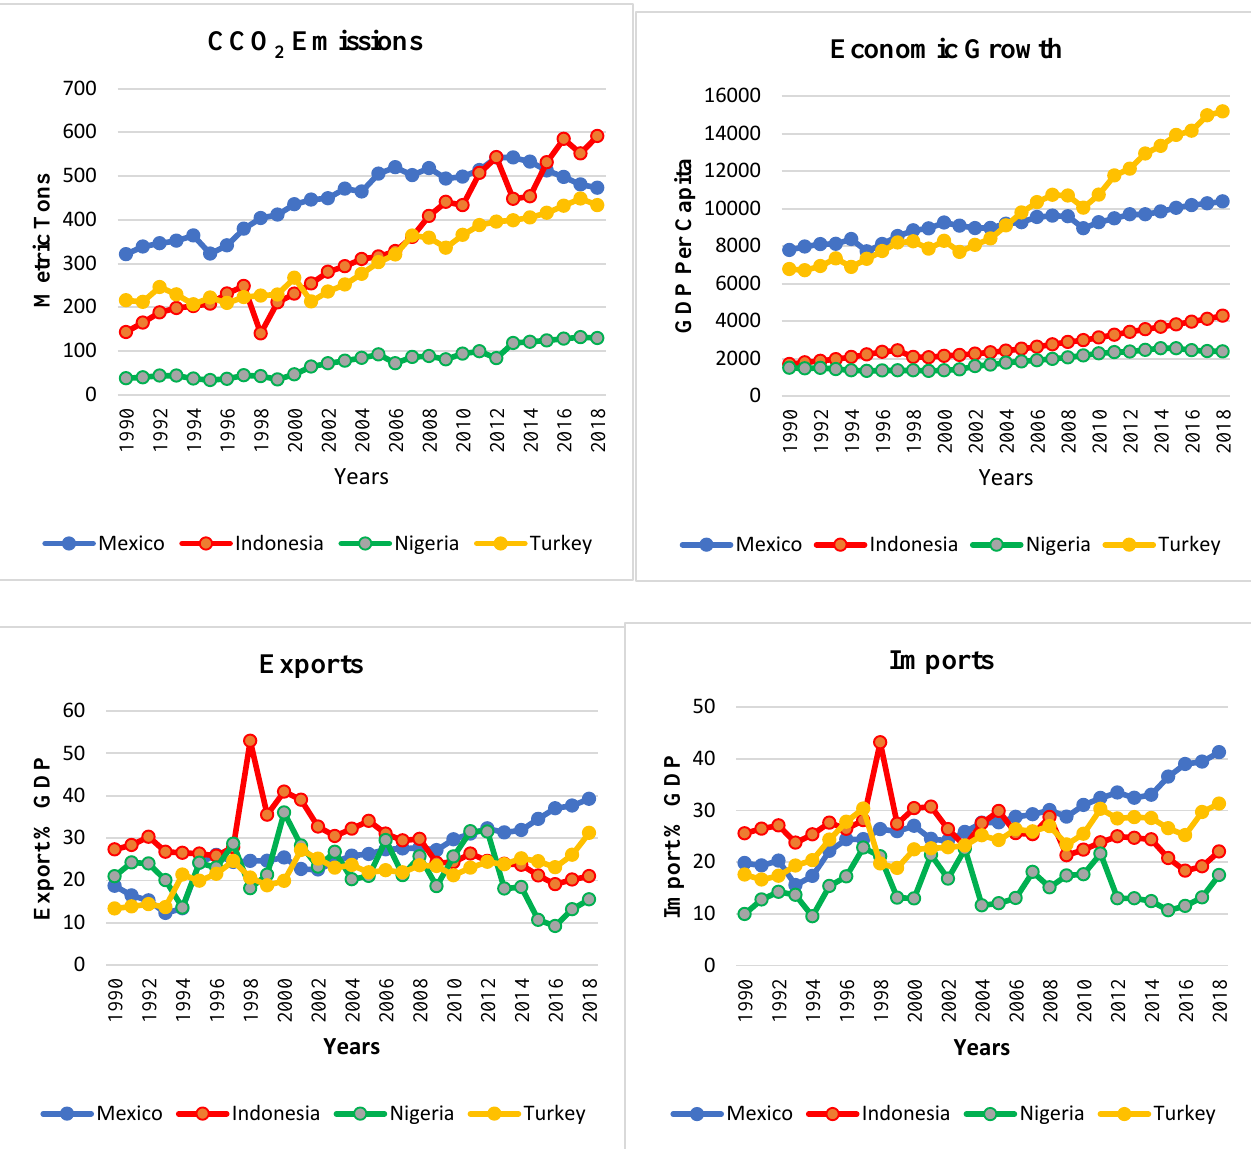
Figure 1. Trend of variables of study.